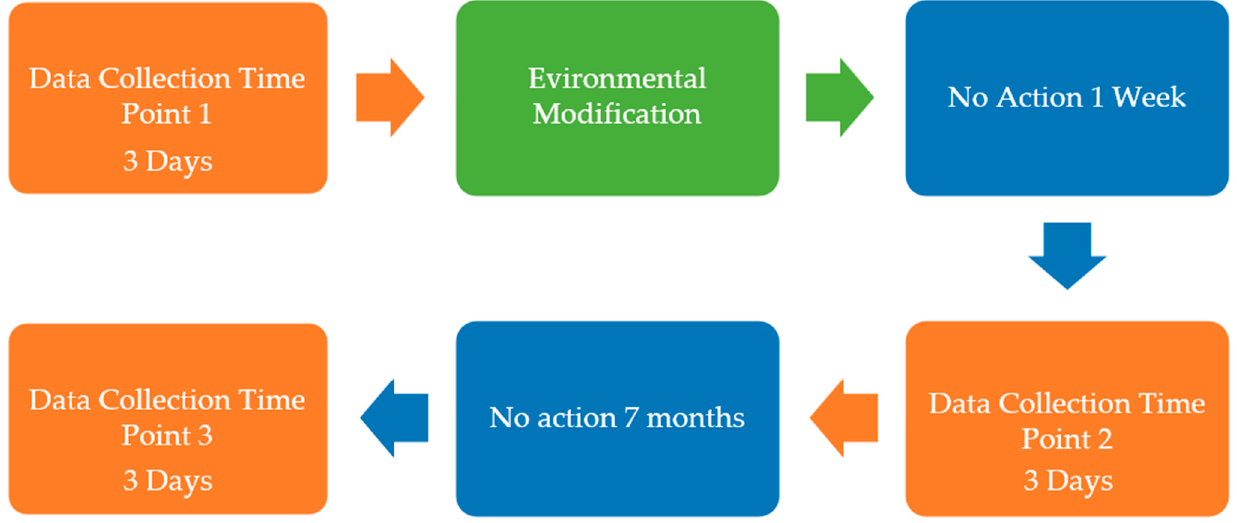
in Figure 2. Timeline of data collection for the evaluation of tortoise behaviour in response to a change in environment. Table 1. Ethogram used for behavioural analysis modified from [8,38,39].